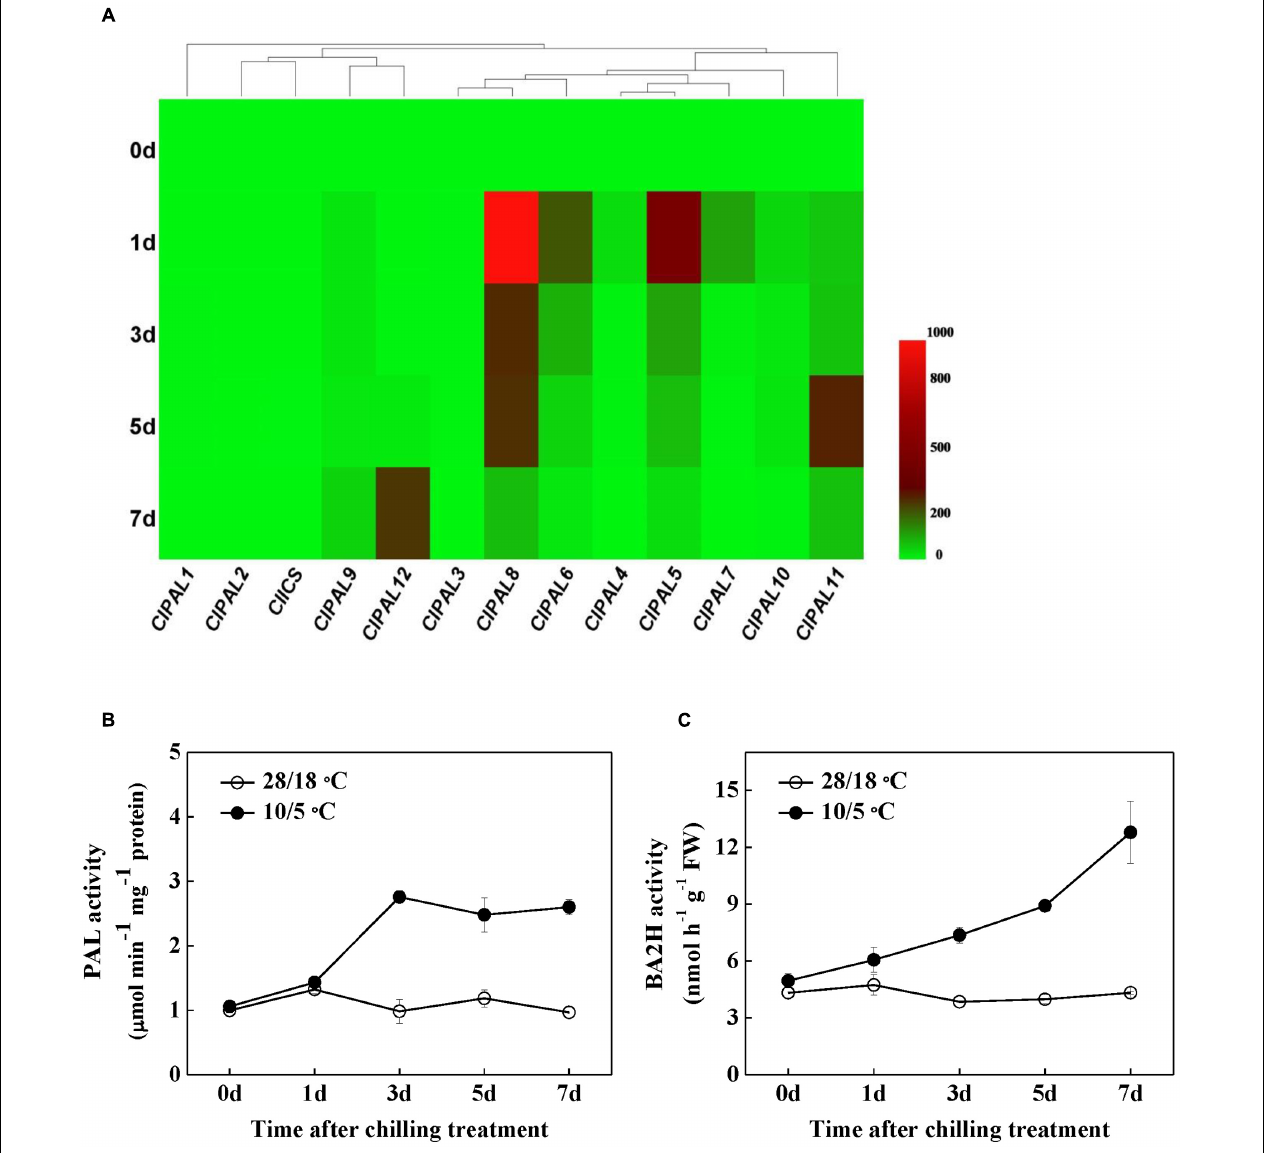
FIGURE 2 | The response of SA biosynthesis to chilling stress. (A) Changes in the relative mRNA levels of PAL and ICS genes using matrix cluster analysis. The intensity of the red or green color represents the extent of up-regulation of the tested gene, and the dendrogram indicates the degree of similarity between the expression profiles of the tested genes. (B,C) Changes in the activities of PAL and BA2H enzymes in response to chilling stress in watermelon plants. Leaf samples were collected at the indicated times. The data are the means of four replicates with SEs. Different letters indicate significant differences between the treatments according to Tukey’s test ( P <